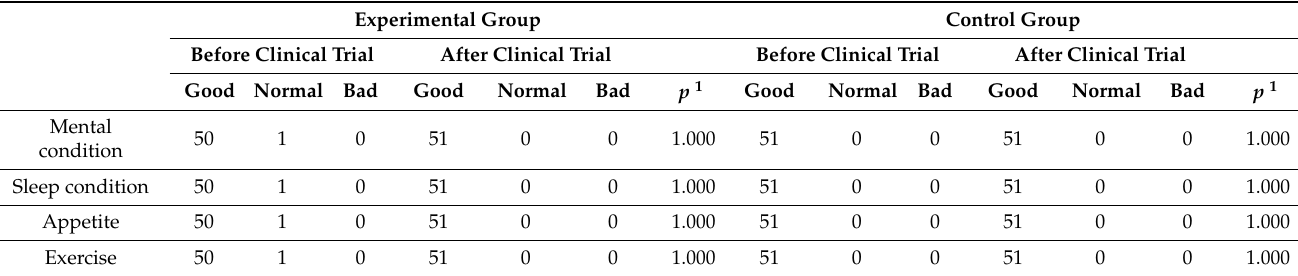
Table 2. General comparison between two groups before and after clinical